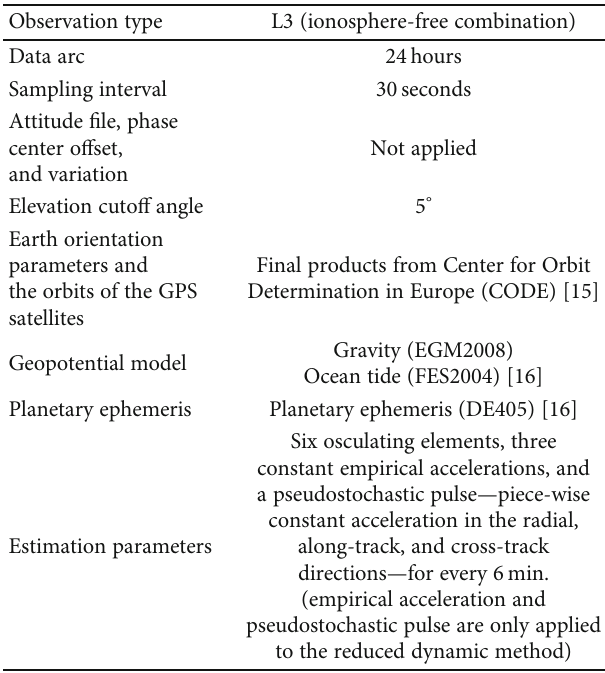
Table 1: POD schemes for both KOMPSAT-5 and GRACE